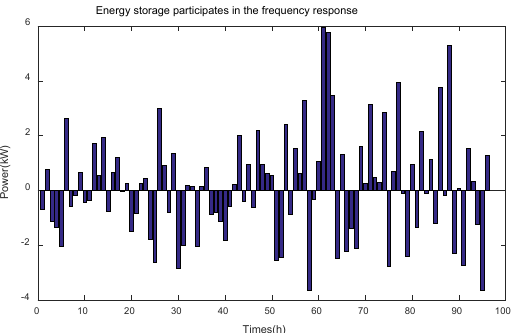
Figure 12. The output of HESS participation in frequency regulation.